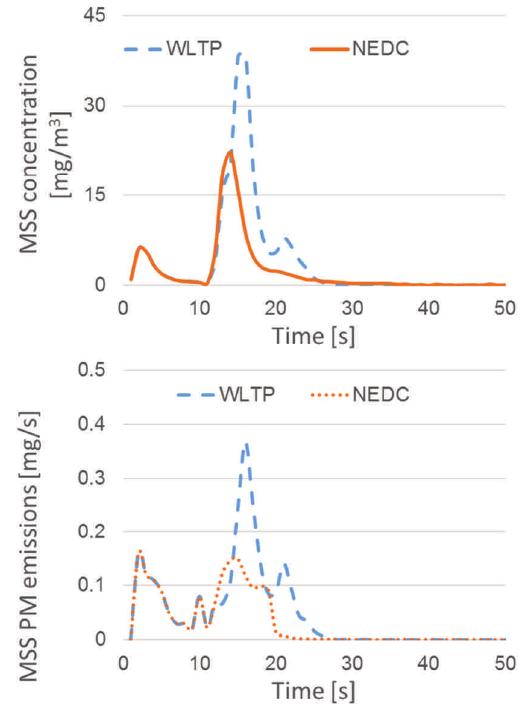
Fig. 12a: Raw MSS readings for the first 50 seconds of the NEDC and WLTP; and 12b: Calculated MSS emissions for the first 50 seconds of the NEDC and